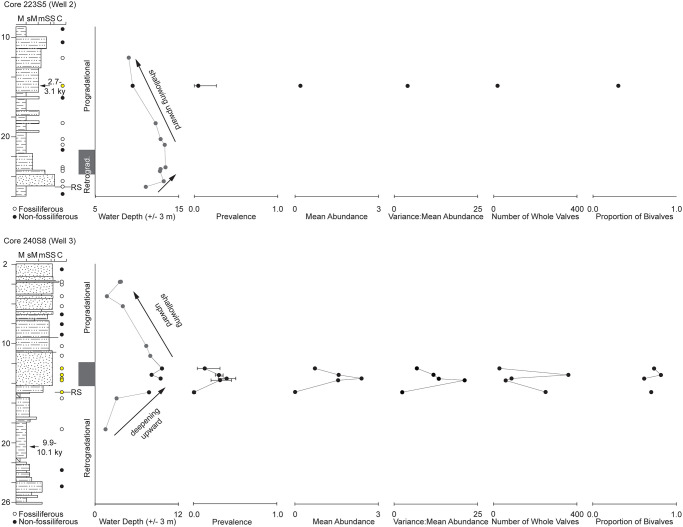
Lithostratigraphy of cores 223S5 (well 2) and 240S8 (well 3), [53]), water depth estimated by multivariate ordination of molluscan fossil counts [36] trematode prevalence and 95% confidence limits, mean trematode abundance, variance to mean abundance ratio, the number of whole valves in the sample, and the proportion of bivalves in a sample made up of C. gallina.The circles parallel to stratigraphic columns indicate samples collected from the core. Solid black circles were non-fossiliferous, hollow white circles were fossiliferous, and hollow yellow circles had C. gallina with trematode-induced pits. RS: Ravinement surface. The gray box represents the transition from retrograding outer estuary facies to aggrading/prograding deltaic facies within shoreface water depths.